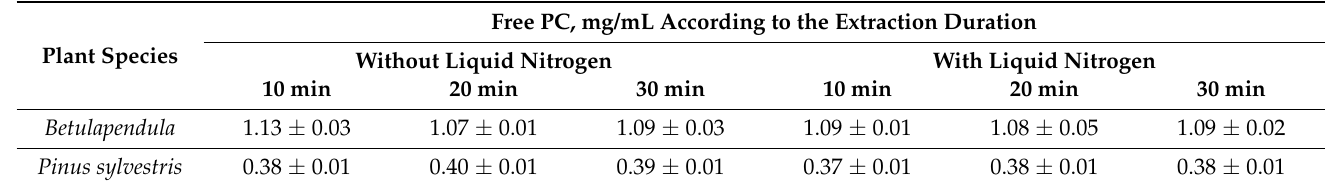
Table 1. The content of free PC in pollen extracts isolated by ultrasound method. Free PC, mg/mL According to the Extraction Duration Plant Species Without Liquid Nitrogen With Liquid Nitrogen 10 min 20 min 30 min 30 min Betulapendula 1.13 ± 0.03 Pinus sylvestris 0.38 ± 0.01